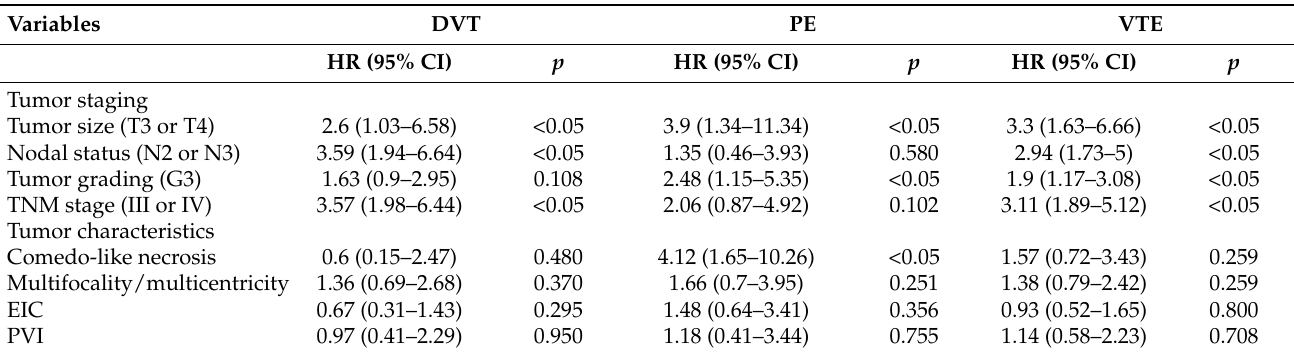
Table 5. Tumor characteristics and tumor recurrences considering only invasive breast tumors. Univariate Cox proportional hazards model analysis considering for new diagnosis of deep vein thrombosis (DVT), pulmonary embolism (PE), or venous thromboembolism (VTE) after breast surgery and possible associated